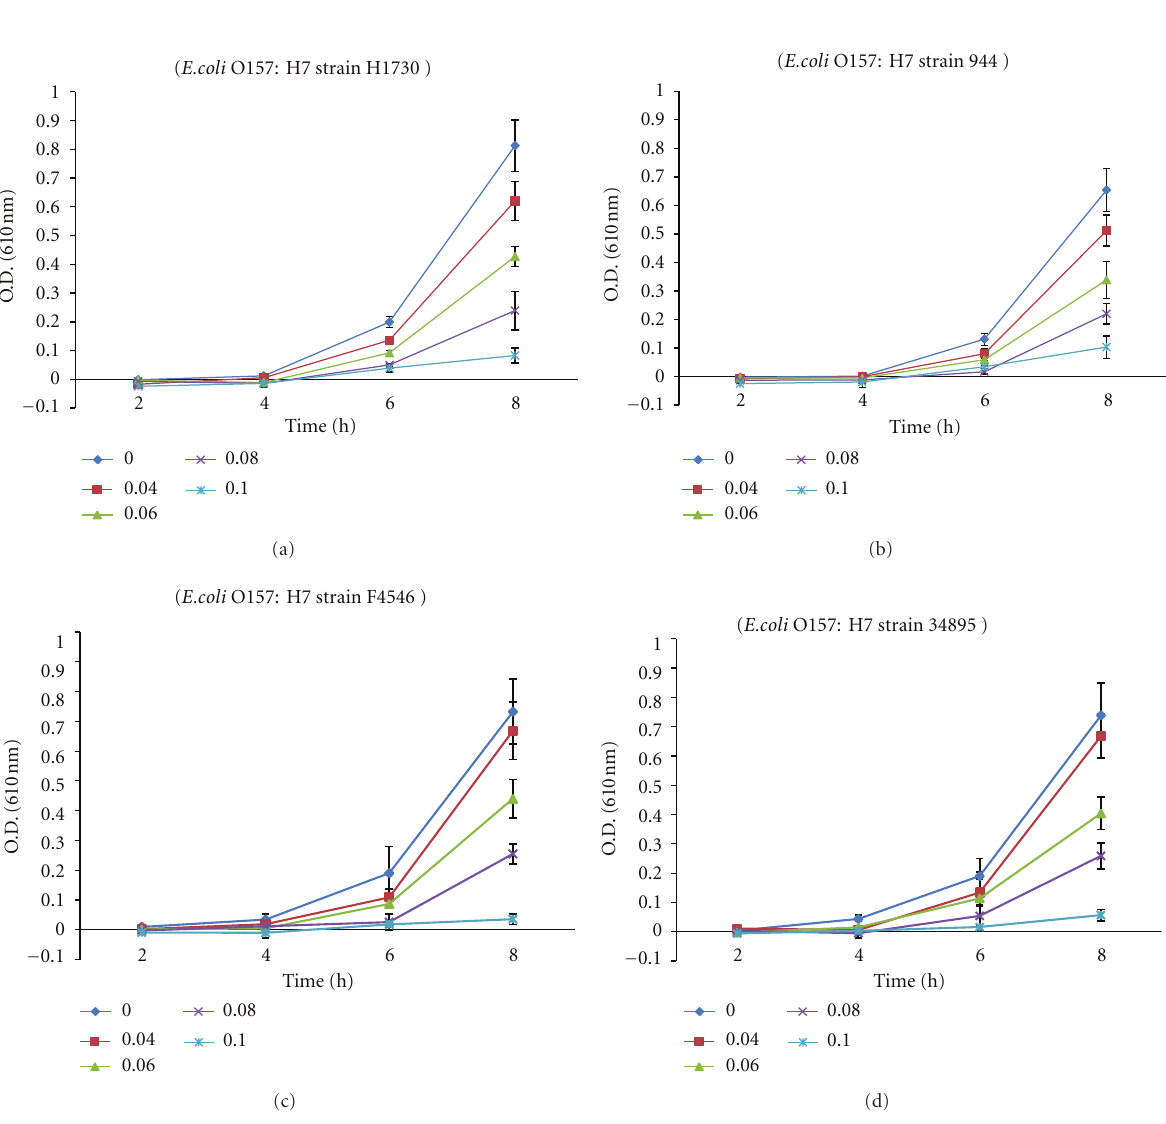
Table 1: Final population of E. coli O157:H7 strains in BHI broth in the presence of xoconostle extract at di ff erent concentrations % (v/v) after 8h of incubations at 37 ◦ C. Data represent the average of three replicates with standard error. Final population (Log CFU/mL) of E. coli O157:H7 strains xoconostle extract Concentration % (v/v) H1730 944 F4546 43895